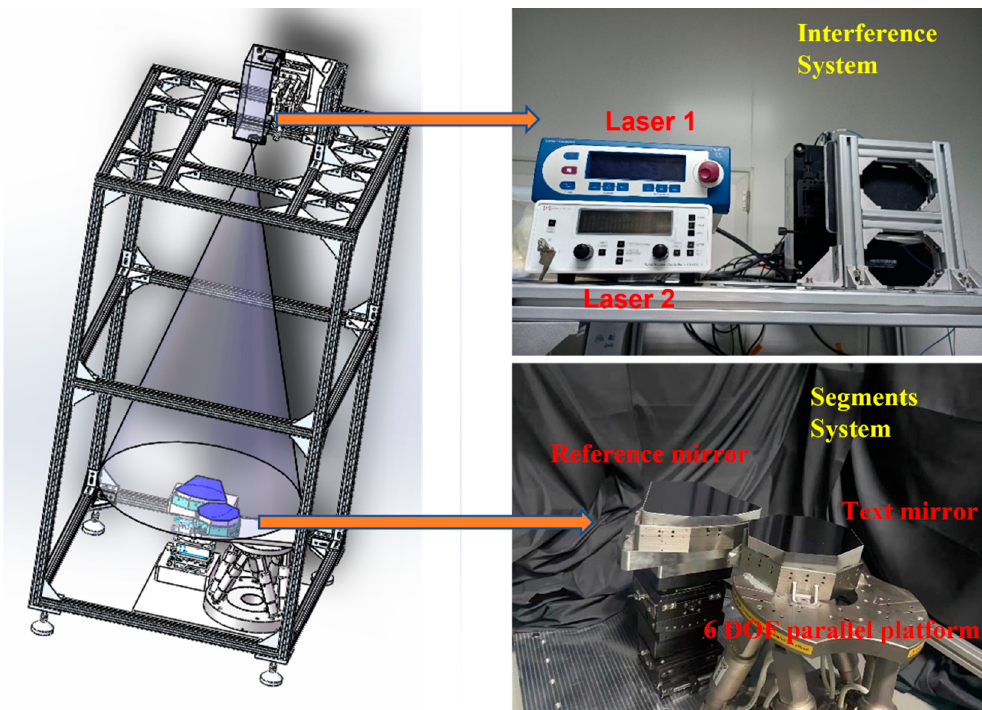
Figure 6. Experimental setup: the laser source and Fizeau-interferometer were placed at the top of the frame, the segmented mirrors and adjustment equipment were placed at the bottom, all of them were on the optical platform, and the entire system size was approximately 2.5 × 0.9 × 0.9 m.